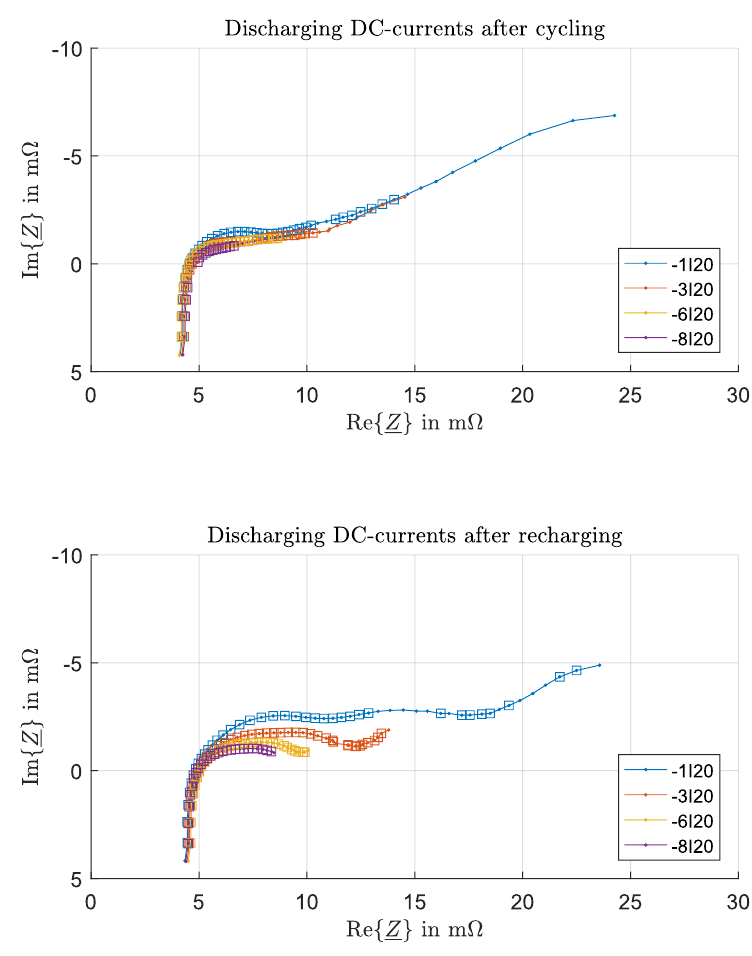
Figure 7. Impedance spectra with discharging DC-currents measured on TC 1 of hard AK3.4 after 120FCE at the end of cycling phase and after recharging. The impedance values, which pass the LTI criterion, are marked with